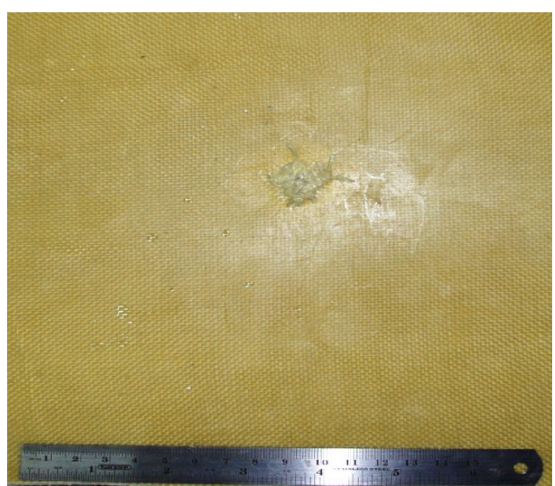
Figure 11. Damage on rear side of 12 layers 0/90 plate.